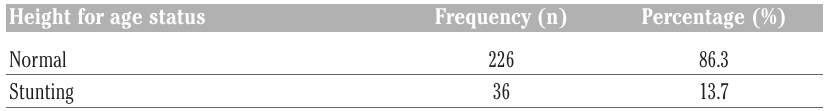
Table 1. The proportion of stunting incidence in children.